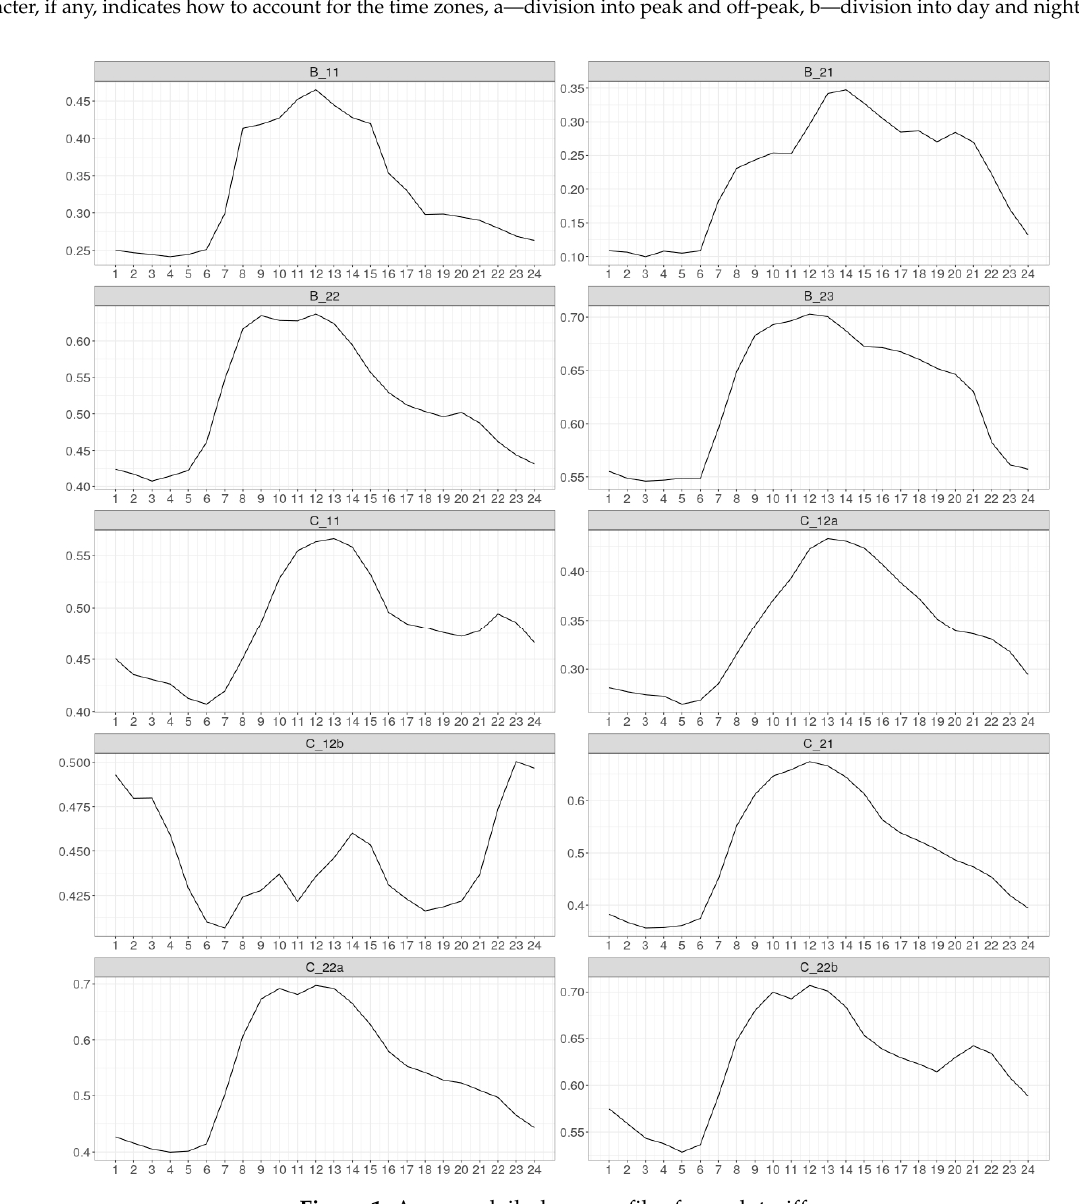
Figure 1. Average daily-hour profiles for each tariff.